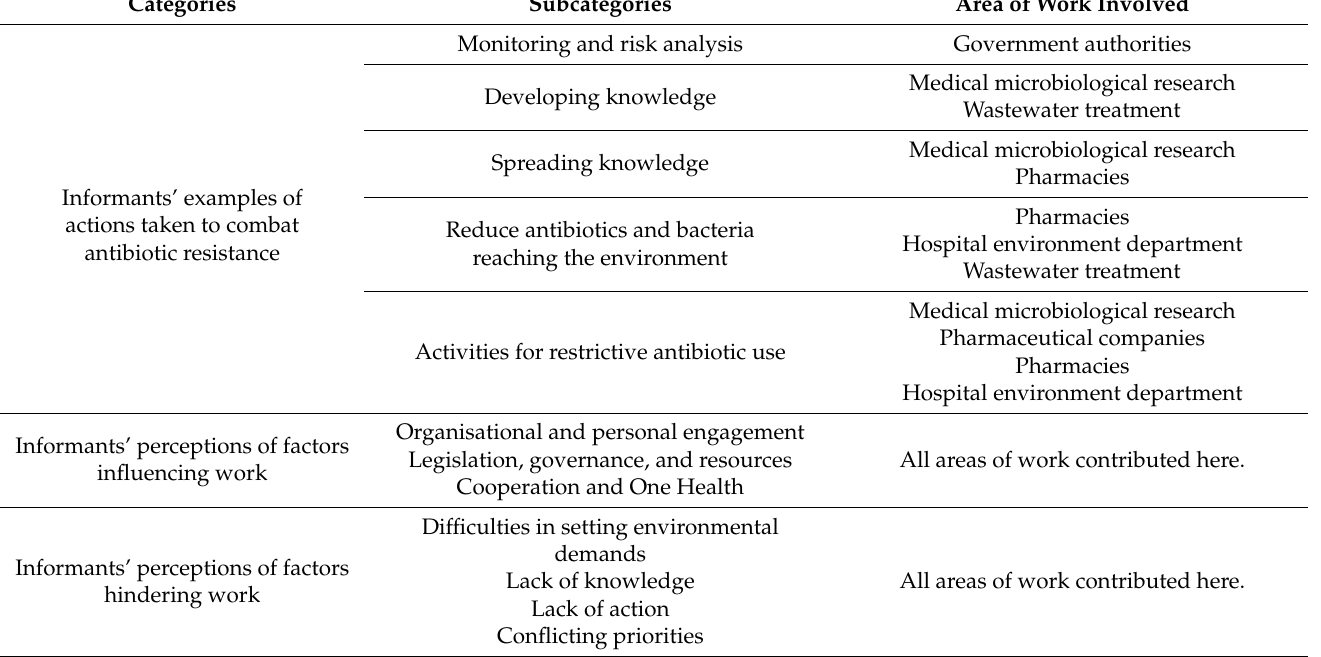
Table 3. Main categories and subcategories describing the content of the